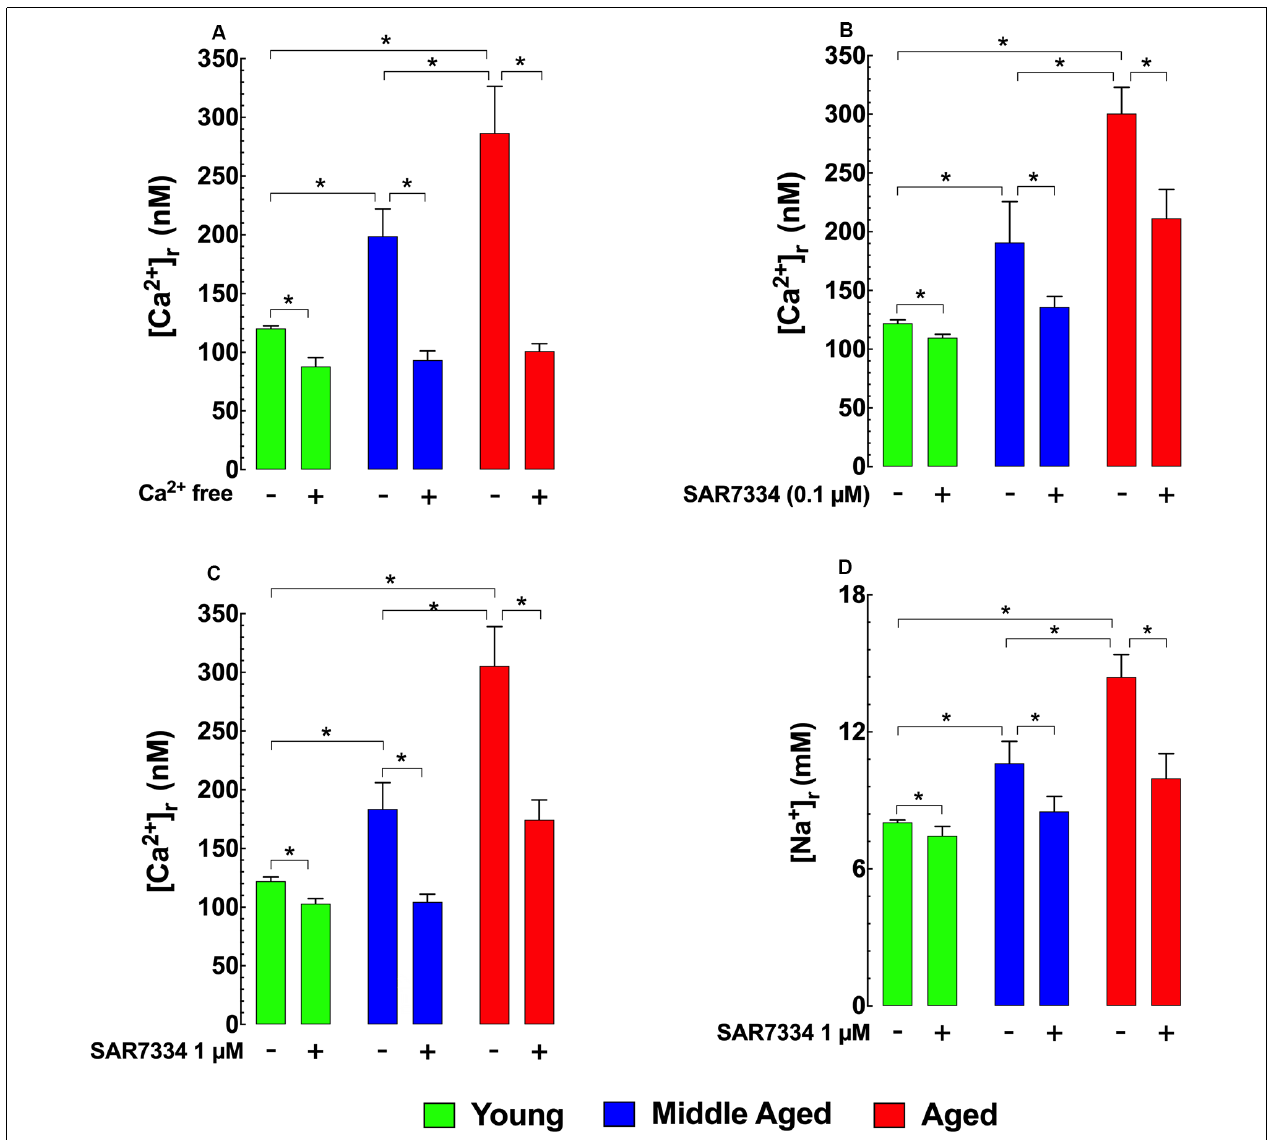
FIGURE 2 | Effects of Ca 2+ free solution and SAR7334 on [Ca 2+ ] r and [Na + ] r in hippocampal pyramidal neurons. Panel (A) shows that removal of extracellular Ca 2+ significantly lowered the [Ca 2+ ] r in all age-group; however, the magnitude of the reduction of [Ca 2+ ] r was more evident in aged than young neurons. Panels